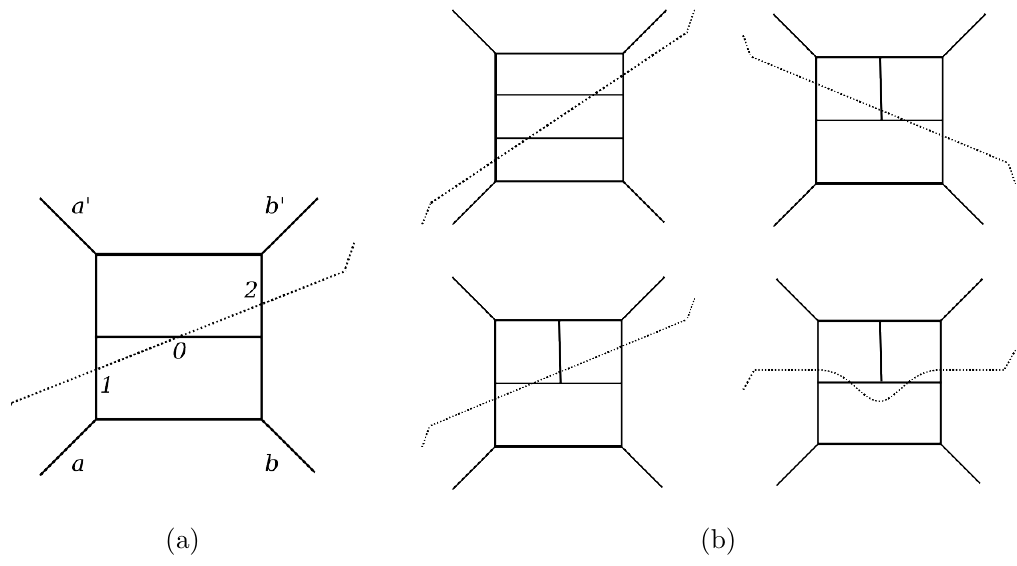
Figure 2 . Extracting squared soft currents from the four-particle integrand: cuts which give the squares of single (a) and double (b) emissions by taking the cut internal propagators to be soft. where the (cid:12)rst factor is recognized as just the cut of the one-loop amplitude (a scalar